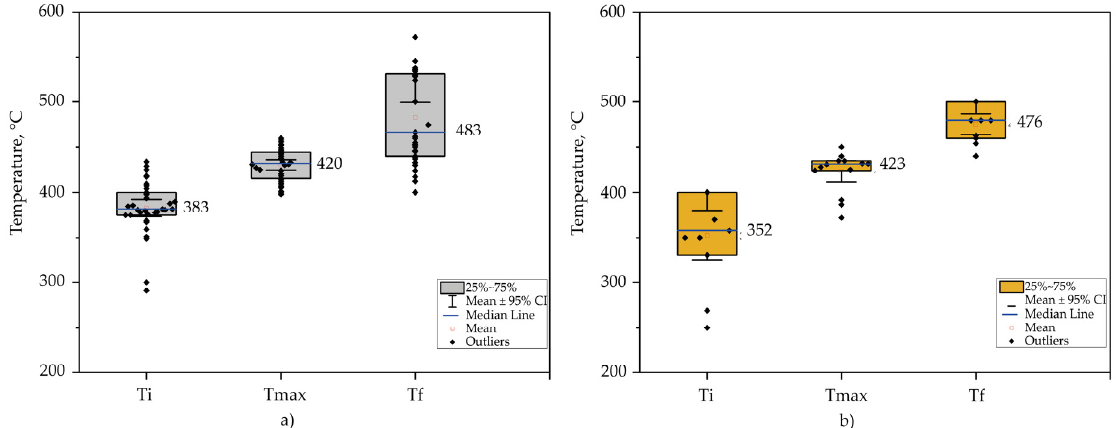
Figure 5. Degradation temperatures by TGA [initial (Ti), maximum (Tmax), and final (Tf)]: ( a ) virgin PS; ( b ) PS waste.